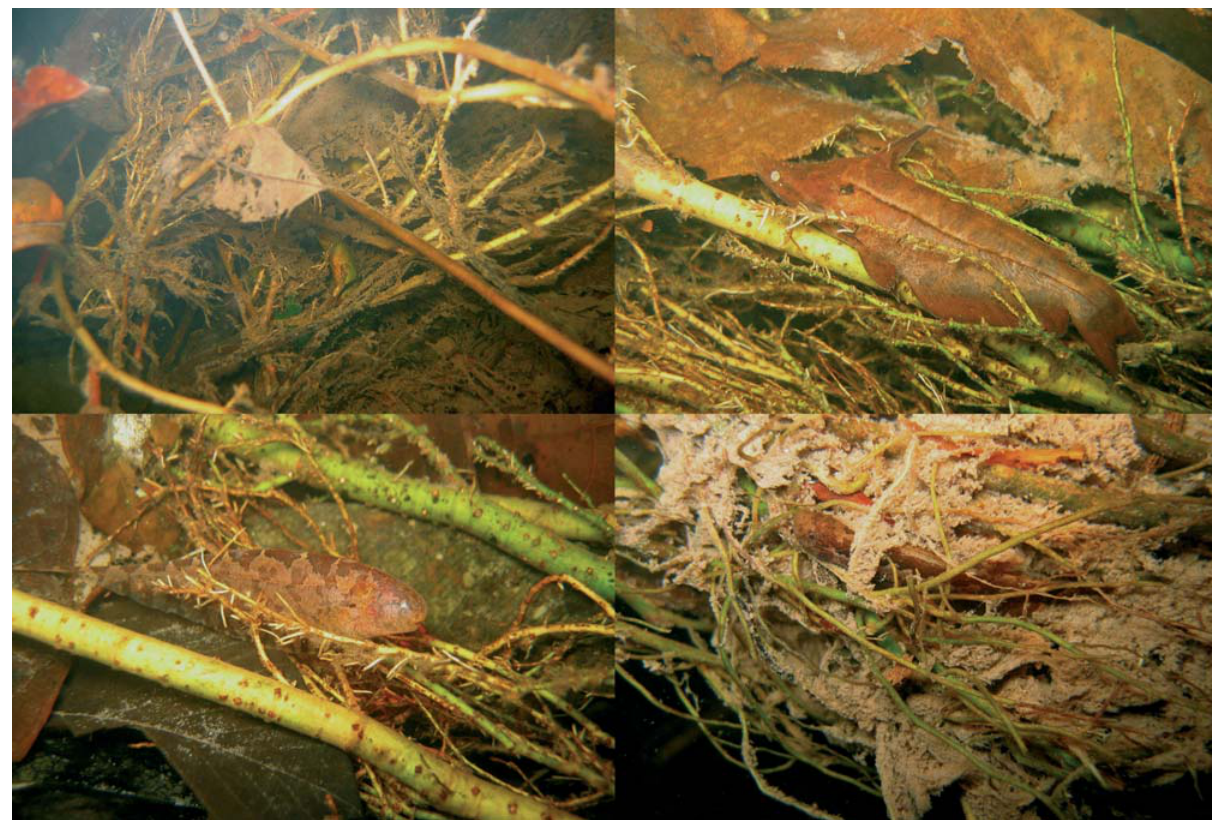
Fig. 1. Habitat and aspect of three root-tangle and leaf-litter inhabiting fish species photographed underwater in an Amazo- nian streamlet: Tetranematichthys quadrifilis (77.7 mm SL, INPA 25107, top right), Steatogenys duidae (129.2 2 mm TL, INPA 25018, bottom left), and Helogenes marmoratus (59.8 mm SL, INPA 25111, bottom